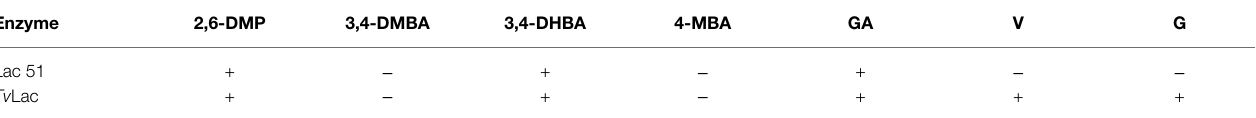
Lignin monomers (3 mM) were incubated with Lac51 or TvLac in 10 mM BisTris-HCl buffer pH 6.5 at 37 ° C. The substrates are abbreviated as follows: 2,6-dimethoxyphenol (2,6- DMP); 3,4-dimethoxybenzalcohol (3,4-DMBA); 3,4-dihydroxybenzaldehyde (3,4-DHBA); 4-methoxybenzylalcohol (4-MBA); gallic acid (GA); vanillin (V); and guaiacol (G). A ‘+’ sign indicates modification of the substrate by the laccase. A “-” sign indicates negative modification of the substrate by the